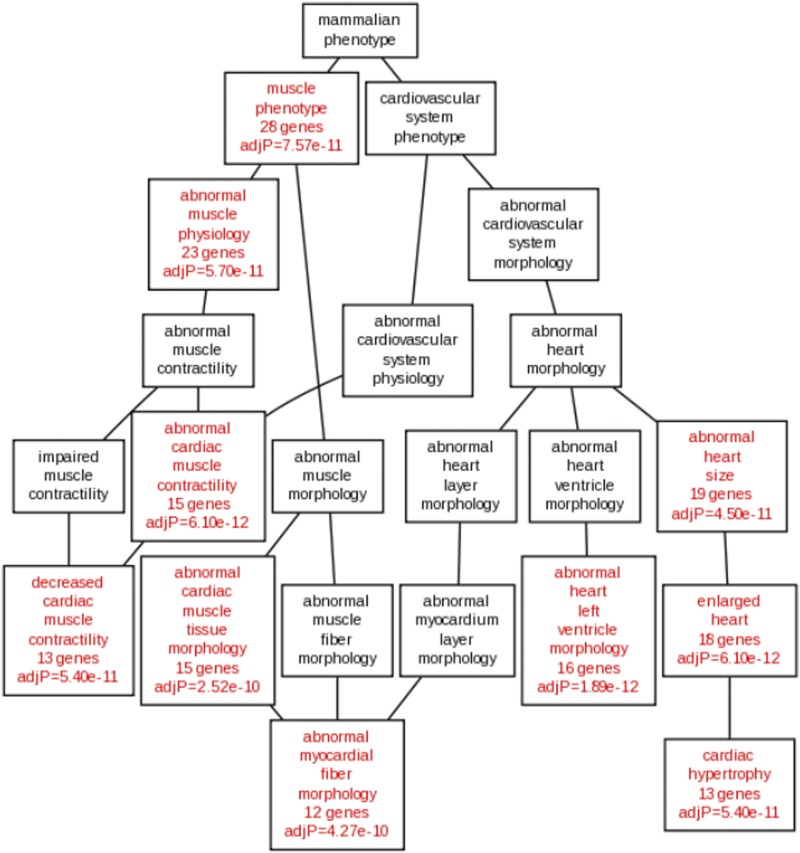
Human phenotypes associated with the pulmonary myocardium coexpression gene network (PM-CGN) are associated with abnormal cardiac function. Phenotypes associated with the PM-CGN are related to muscle and cardiovascular system dysfunction. Pathways enriched with genes from the PM-CGN are shown in red.